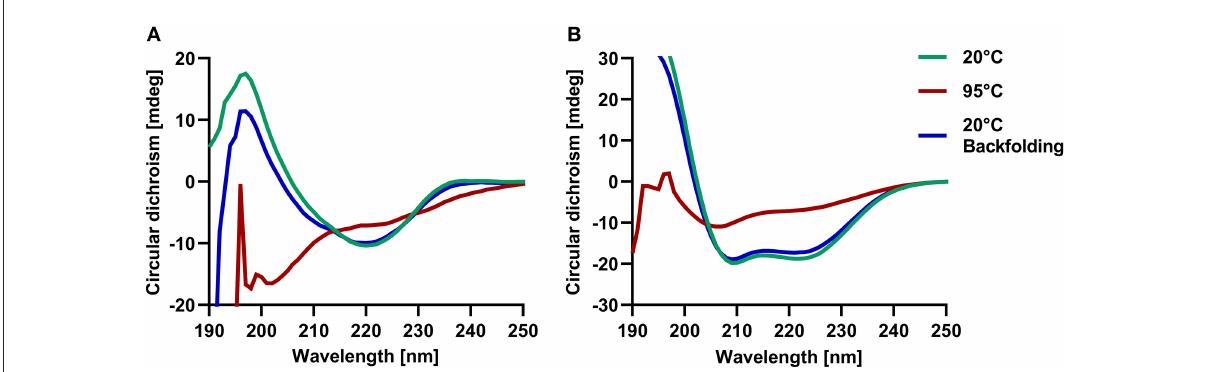
FIGURE3 Circular dichroism spectroscopy confirmed the beta-sheet and alpha-helical structures of respective lipocalins and secretoglobins and revealed a high thermal stability of allergens. Examples of circular dichroism spectra at 20 ◦ C (green) and after temperature ramping at 95 ◦ C (red) and